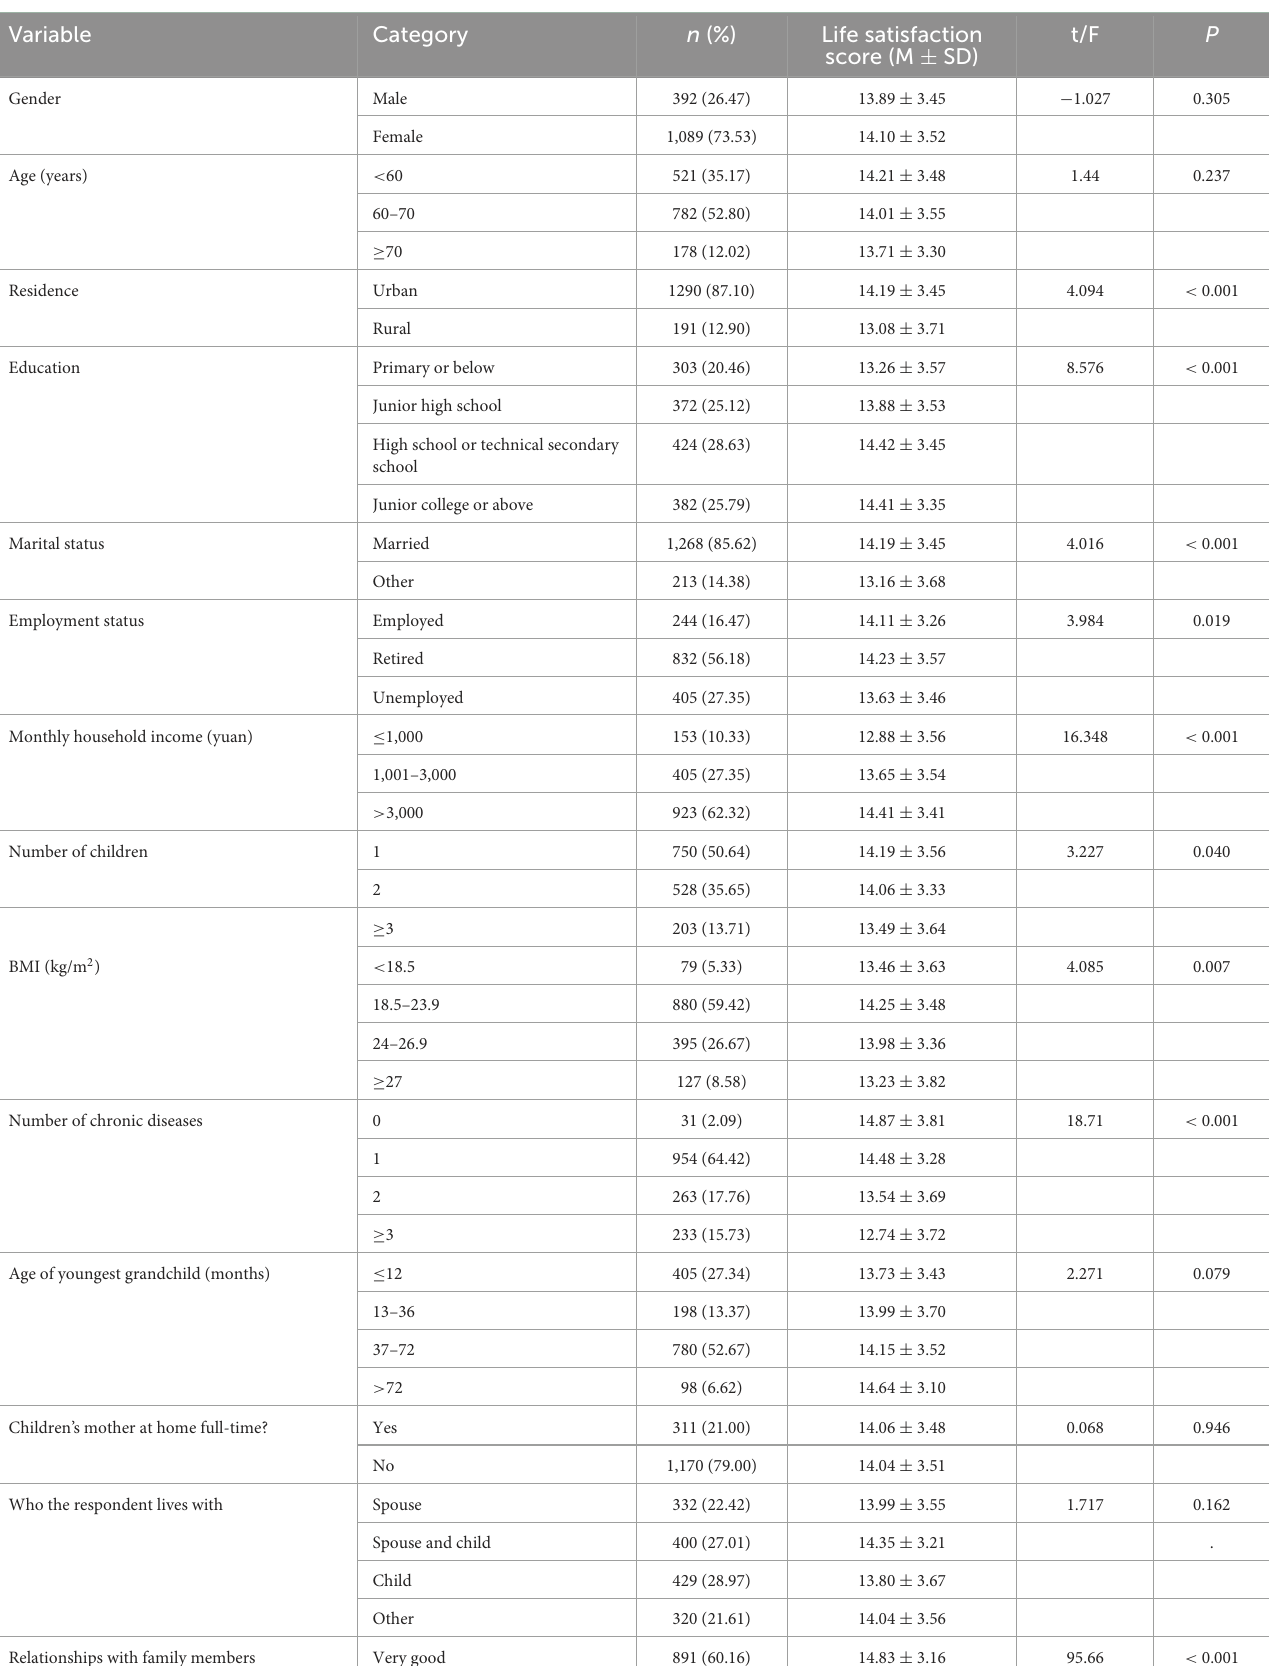
TABLE 1 Univariate analysis of factors influencing life satisfaction among grandparent caregivers.